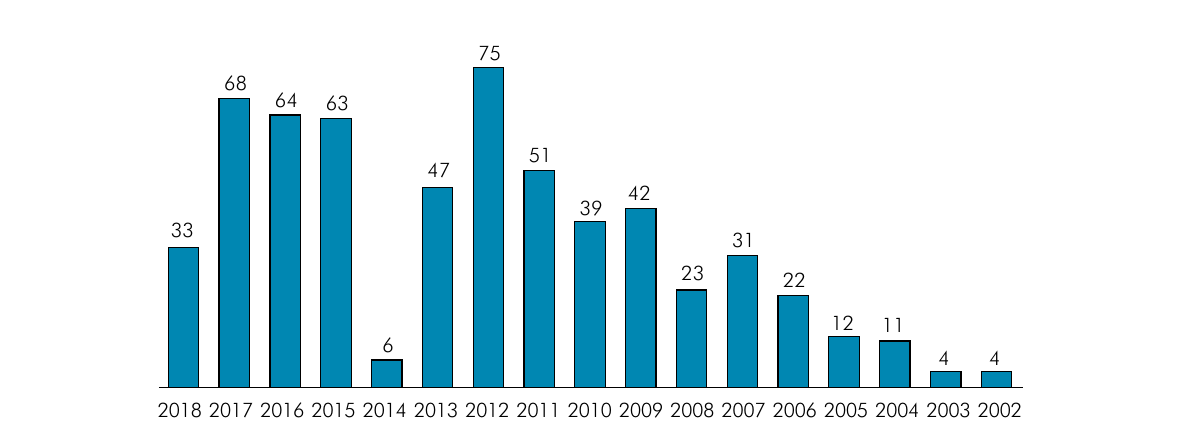
Figure 4. Publications numbers increase according to advantages in proteomics technique, increasing the possibility of discovering new diseases biomarkers. The rose in number was at 2012 with 75 new published studies in saliva